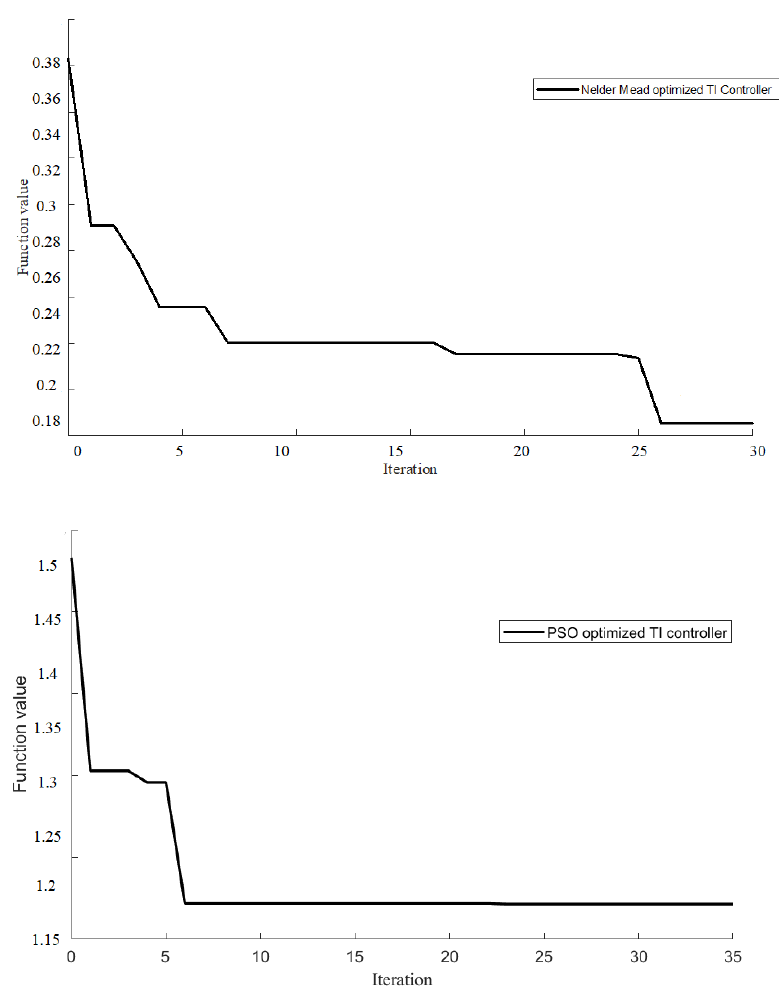
Figure 7. Optimization performance plot of the proposed TI controller using Nelder–Mead and PSO.